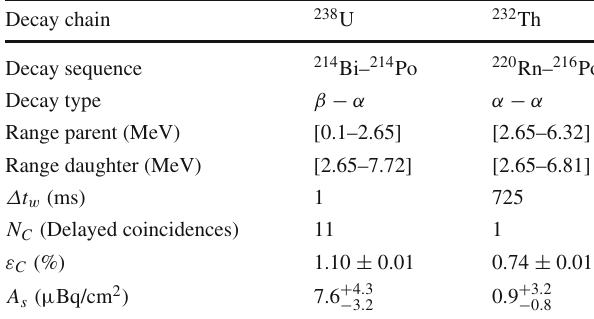
Table 1 Summary of the analysis of delayed coincidences in the mea- surement of a low activity copper sample. We list the selection criteria and the results in the search for 214 Bi– 214 Po and 220 Rn– 216 Po delayed coincidences. The number of detected coincidences ( N C ) are finally combined with absolute efficiencies ( ε C ) to extract the